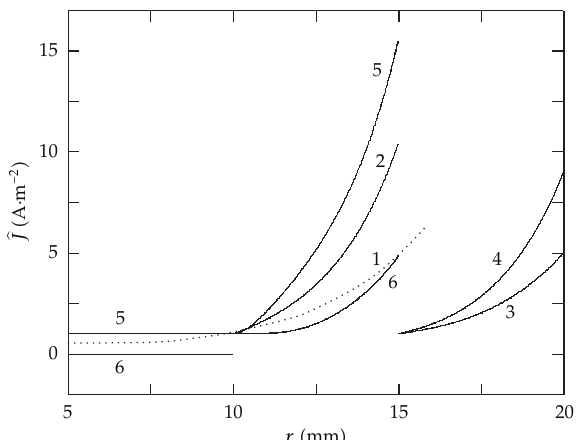
Figure 4: Solution of Example 3.2; variants 1–6 are specified in Table 1; the number of partial conductors in inner and in outer conductor equals